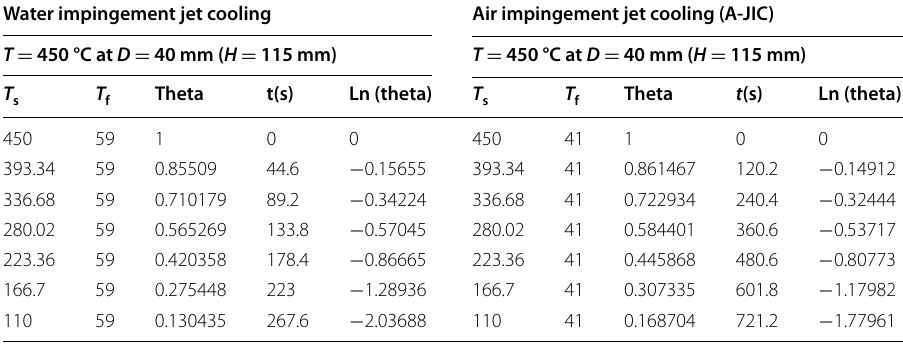
Table 7 Ln (theta) temperature time for D 40 mm controlled at 110 °C A-JIC = Water impingement jet cooling Air impingement jet cooling (A-JIC) T 450 °C at D 40 mm ( H 115 mm) T 450 °C at D 40 mm ( H 115 mm) = = = = = =